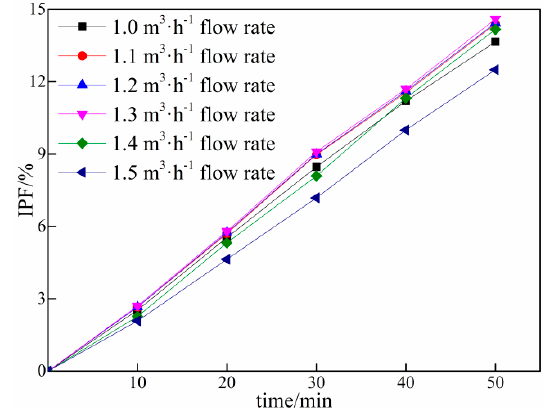
Figure 10. Relationship between IPF and ice-making time at different flow rates.